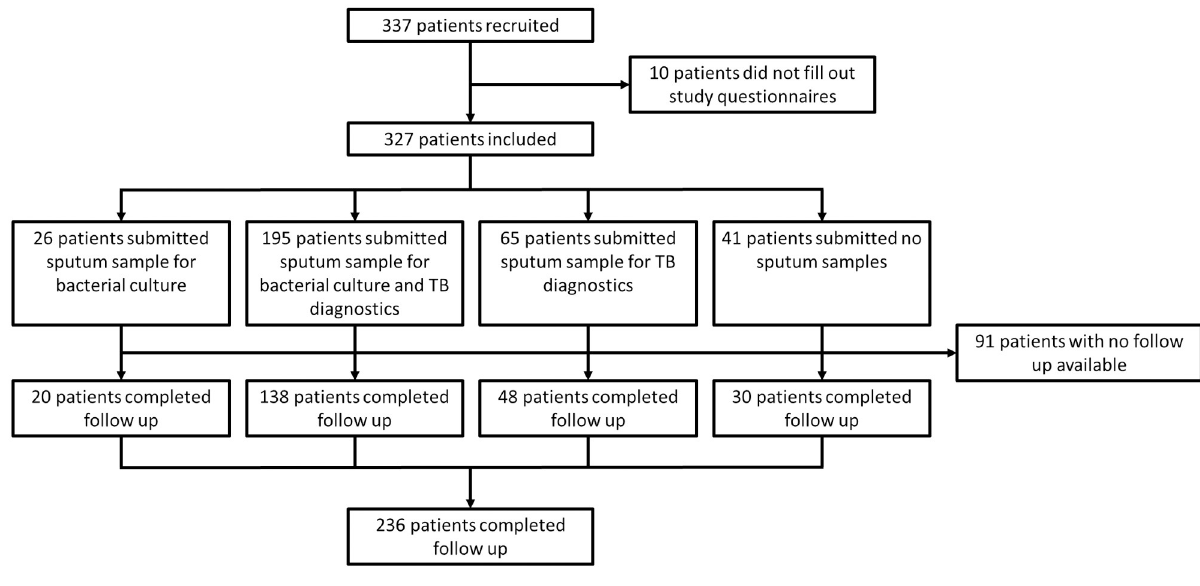
Fig 1. Study flow